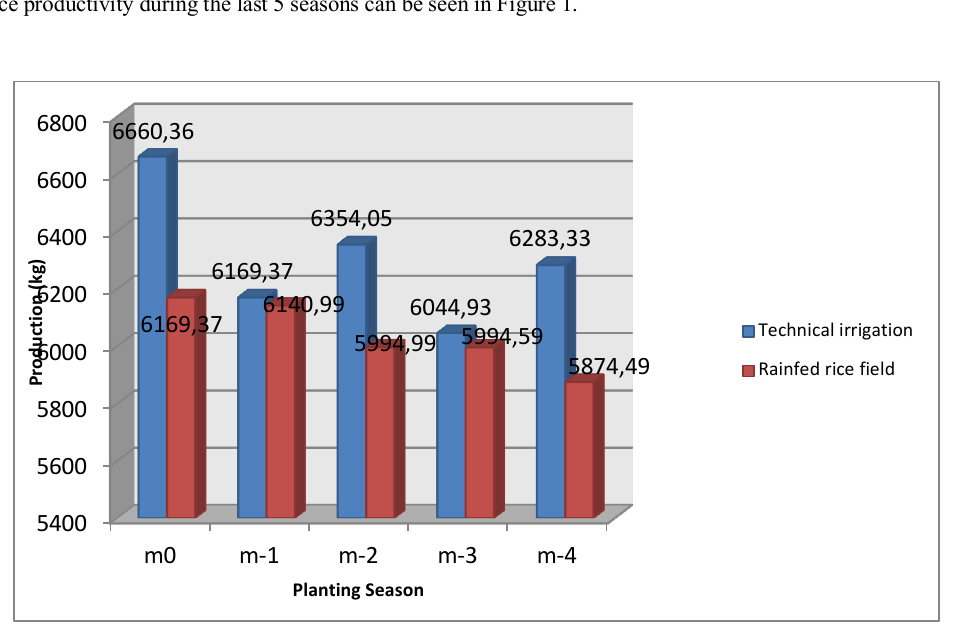
Figure 1: Fluctuations in paddy rice production per hectare of the rainy season during the last 5 seasons on technical irrigated rice field and rainfed rice field